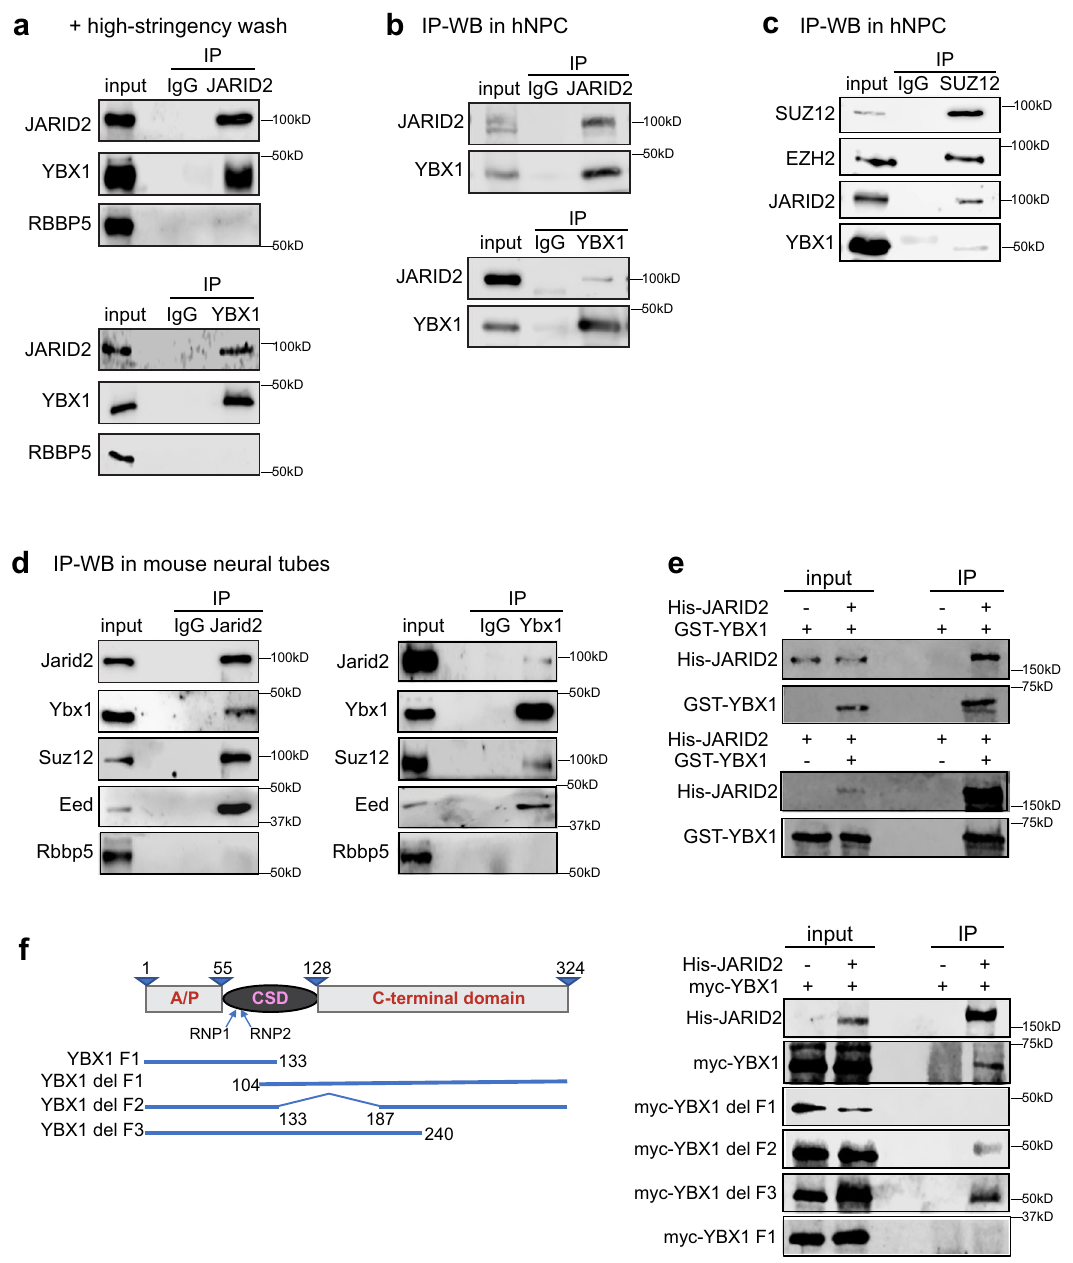
Fig. 6 PRC2 complex binds to Ybx1 in human stem cells and mouse neural tubes. WB analysis of IgG, JARID2, and YBX1 co-IP of a the hESC nuclear extract with high-stringency washes and b the hNPC nuclear extract. c WB analysis of IgG and SUZ12 co-IP of the hNPC nuclear extract. d WB analysis of IgG, Jarid2, and Ybx1 co-IP of the mouse neural tube nuclear extract. WB analysis of His-JARID2 and e GST-YBX1 or f myc-tagged YBX1 protein fragments. Source data are provided in Source Data fi